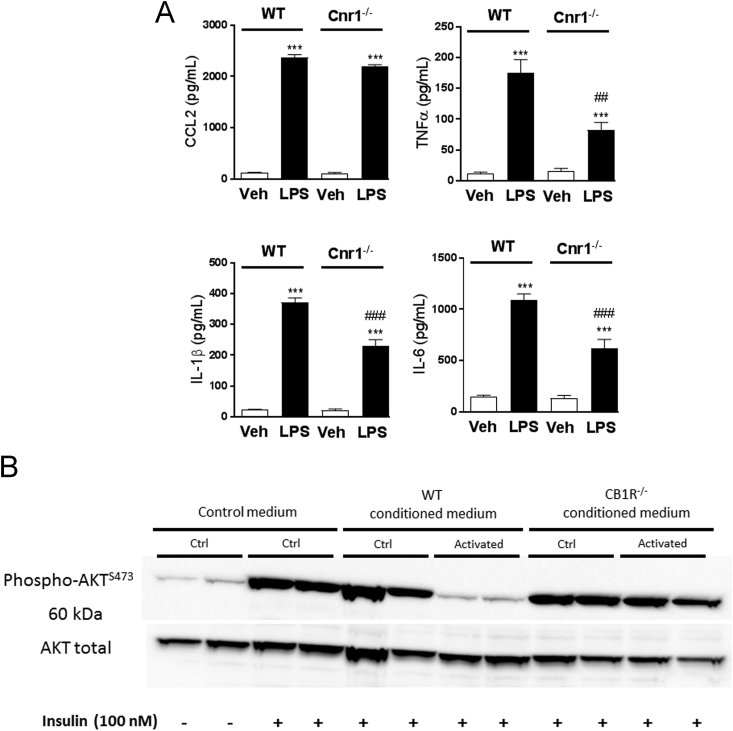
Changes in inflammatory tone directly influence hepatocyte response to insulin. A Cytokine and chemokine production by Kupffer cells isolated from wildtype (WT, empty columns) or CB1R−/– mice (Cnr1−/−, black columns) after 48 h of treatment with saline or LPS (50 ng/mL). Columns and bars represent means ± SEM from 3 individual experiments with n = 3 replicates per condition. B Representative western blot showing Akt phosphorylation in response to insulin challenge (100 nM, 30 min) in hepatocytes incubated for 24 h in conditioned medium obtained from LPS-treated Kupffer cells as described in A. Columns and bars represent means ± SEM. Significant differences from values in vehicle treated cells *P < 0.05, **P < 0.01, ***P < 0.001 or LPS treated cells #P < 0.05, ##P < 0.01, ###P < 0.001.